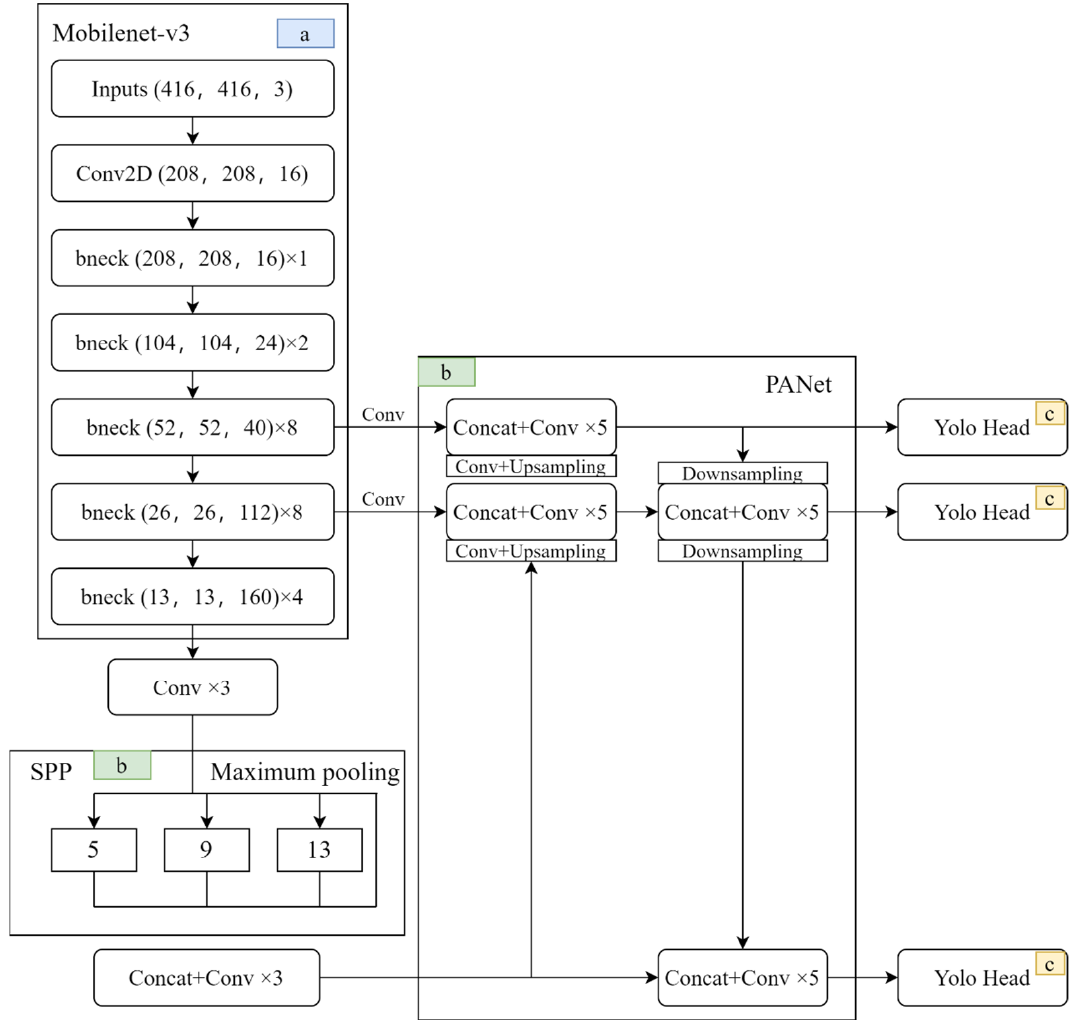
Figure 10. Structure of the improved YOLO-v4 ( a ) Mobilenet-v3, ( b ) PANet, SPP Maximum pooling, ( c ) Yolo Head.